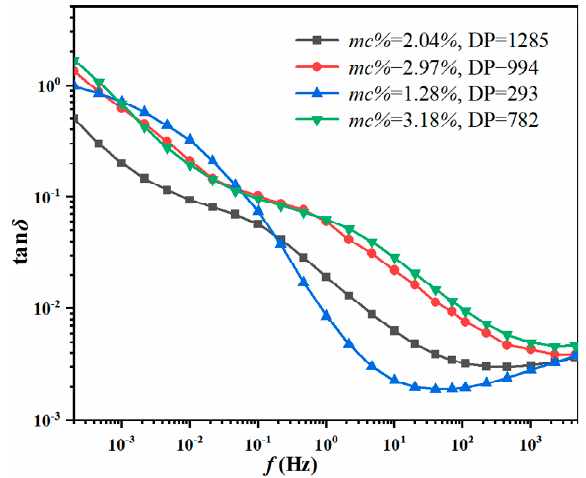
Figure 7. Tan δ curves of the lab samples.